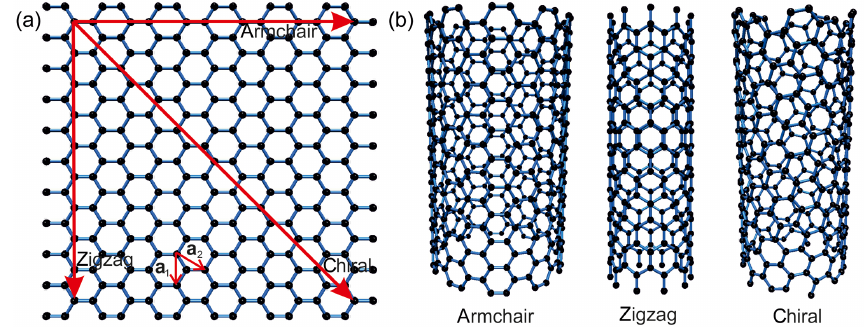
Figure 1. The scheme of lattice structures (a) graphene sheet, (b) single-walled carbon nanotubes.